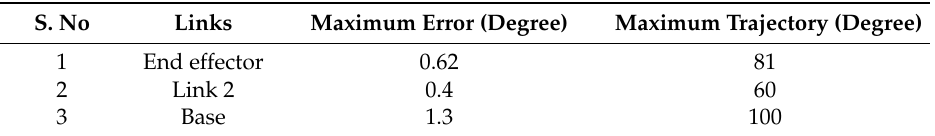
Table 4. Error between master–slave